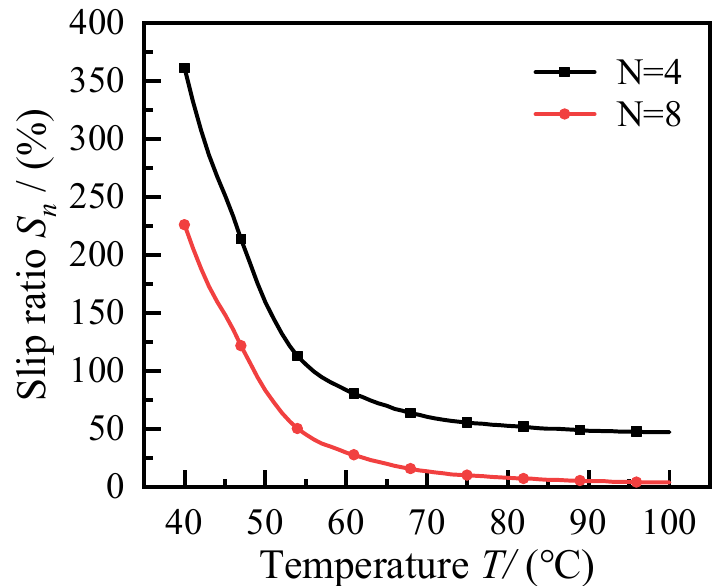
Figure 12. Slip rate of SMA fan clutch.